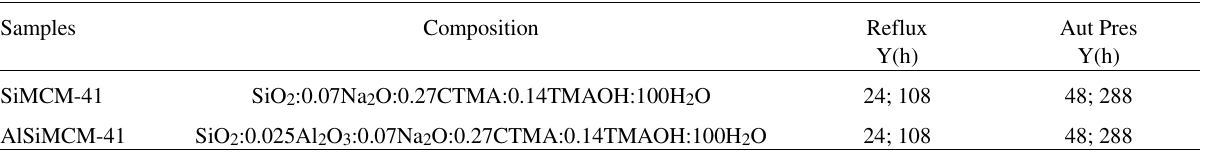
Table 1. Molar compositions and synthesis time. Samples Composition